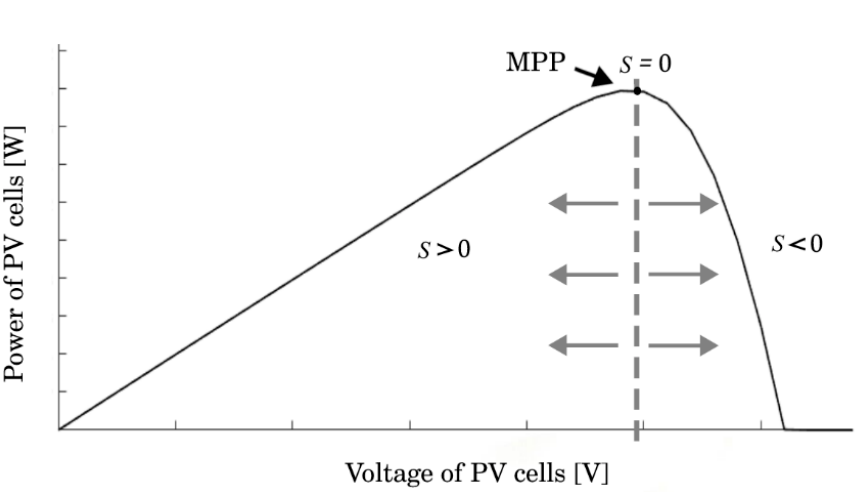
Figure 6. Lyapunov function in the voltage vs. power curve of the PV cells.